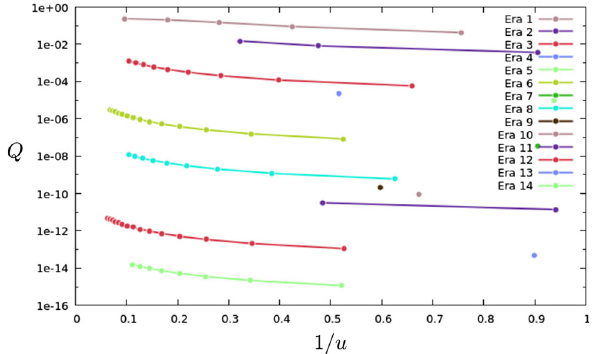
Fig. 9 In this figure the graphical results of a sample of the numerical simulationareportrayed.ThepolymerBKLmap(116)hasbeenevolved starting from the initial value ( u = 10 , Q = 0 . 24 ) . Every point is the result of a single iteration of the BKL map. The role played by the Polymer BKL map (116) is just to take a single point and map it to the next one. A total of 14 Kasner eras are shown, each with a different color. The fact that, starting from the upmost point, the map on Q is almost always decreasing is very evident from the downwards-going ladder-like shape of the